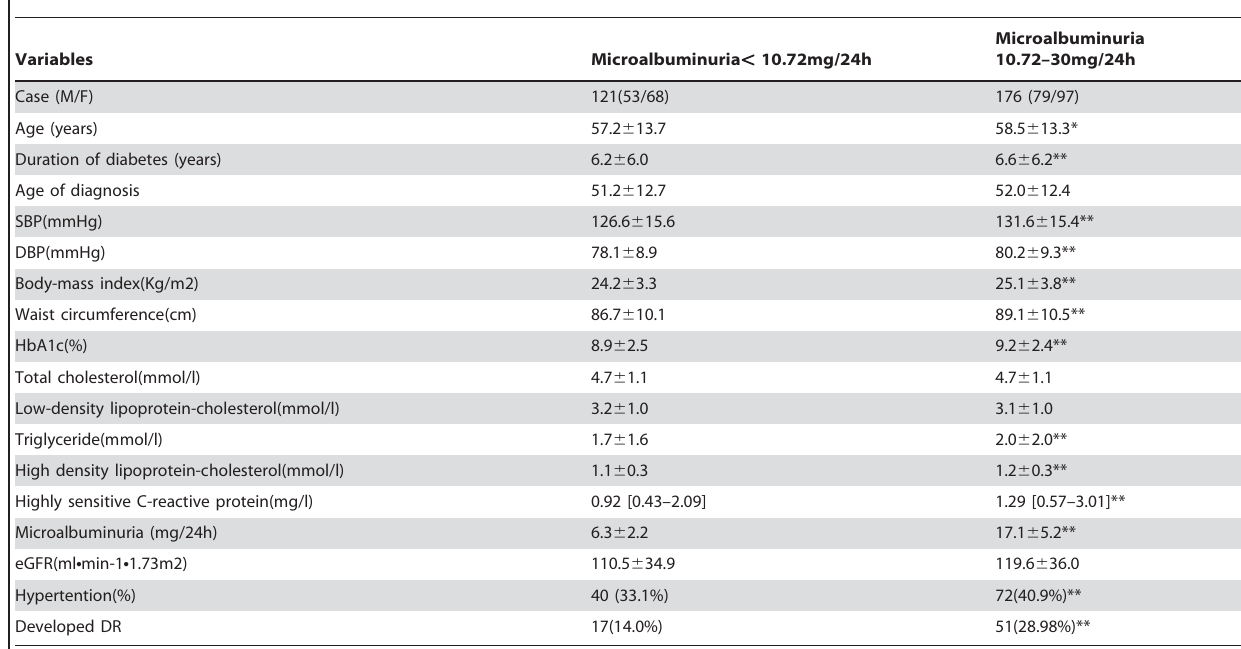
Table 4. Clinical characteristics of type 2 diabetic patients without retinopathy at baseline in prospective